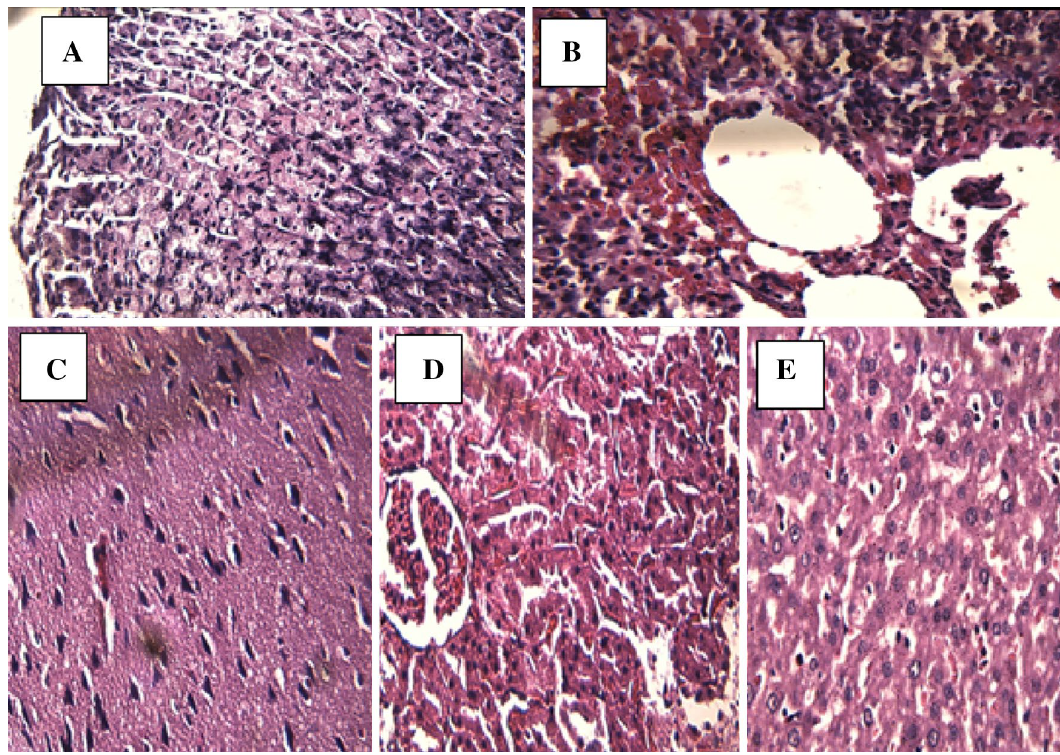
Fig. 2 Hematocrit levels (%) of rats induced to experimen‑ tal anemia for eight weeks. A significant decrease is observed from the second week of induction, obtaining less than 33% of hematocrit in the eighth week. Each point represents the mean ± SEM of three rats, * p ≤ 0.05, ** p ≤